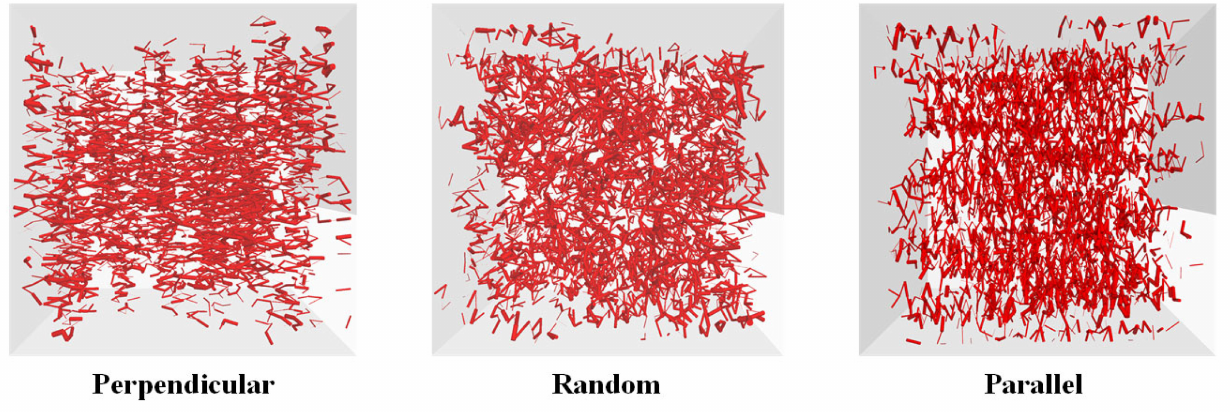
Figure 13. Distribution of fiber-sand contacts at the initial state (scaled by force